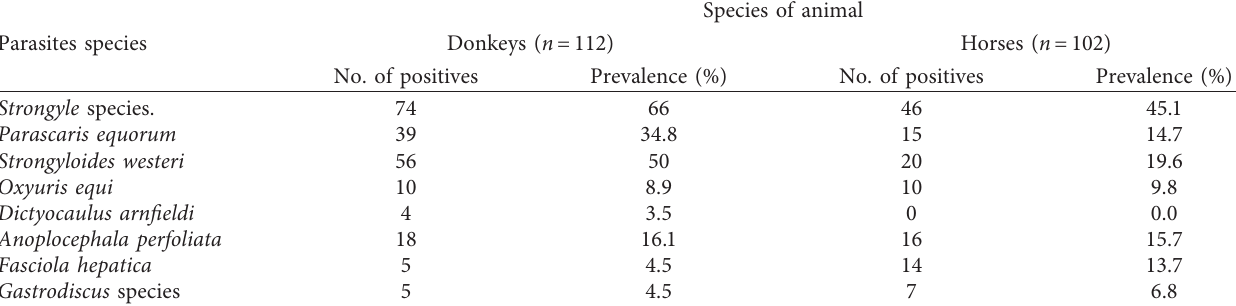
Species of animal